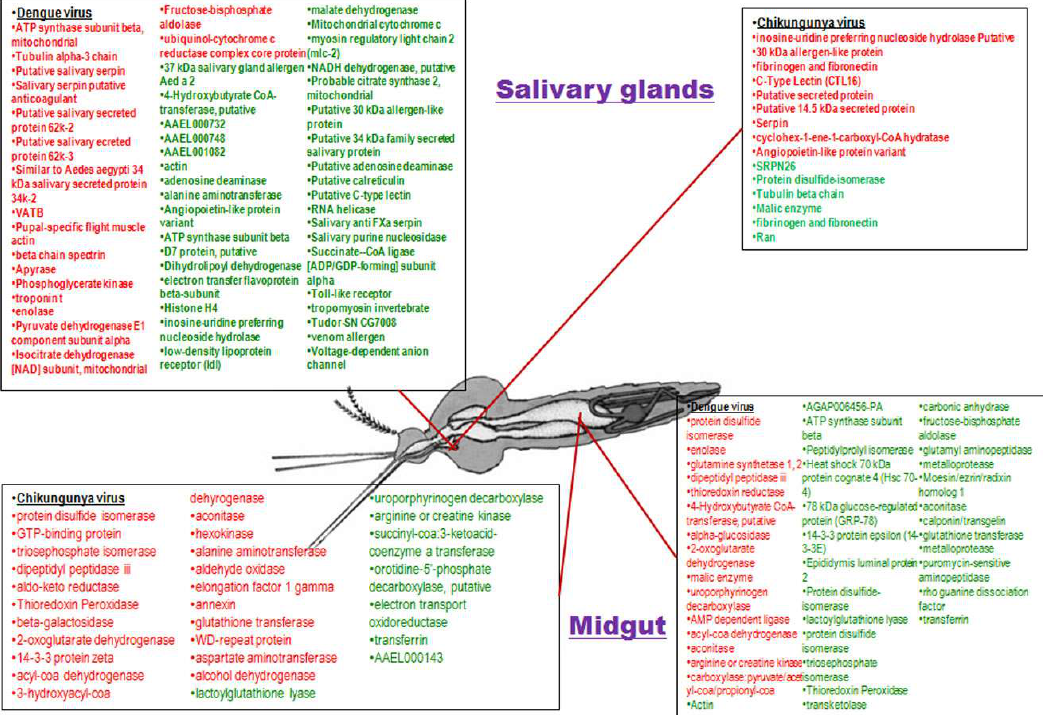
Figure 5. The up regulated ( red fonts ) and down regulated ( green fonts ) proteins of mosquito’s salivary gland and midgut upon chikungunya and dengue infection.